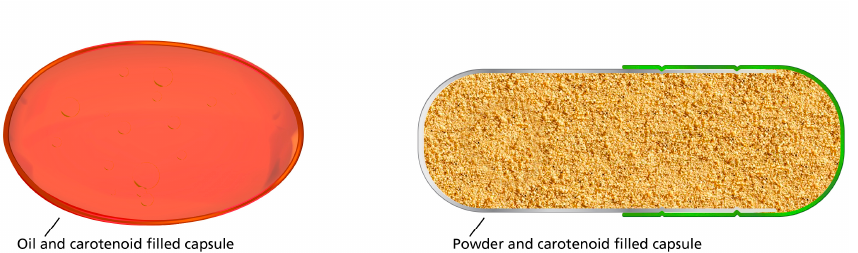
Figure 2. Graphic representation of an oil filled soft gel capsule and a two part powder filled capsule.